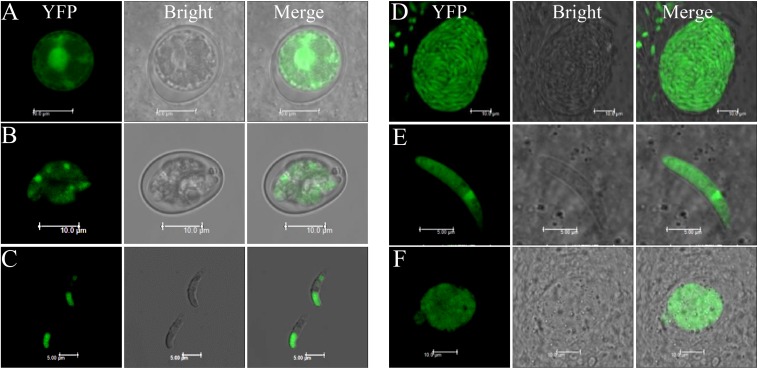
Cas9 protein expression in all stages of EtHCYA. Chicken were infected with 10,000 Et-HCYA clone #3, then the cecal smears were prepared at 96, 120, and 156 h.p.i. for the detection of merozoites, gametocytes, and unsporulated oocysts, respectively. Oocysts were collected and purified from feces. Sporozoites were purified from sporulated oocysts. (A) Unsporulated oocyst; (B) sporulated oocyst; (C) sporozoites; (D) schizont; (E) merozoite; and (F) gametocyte.